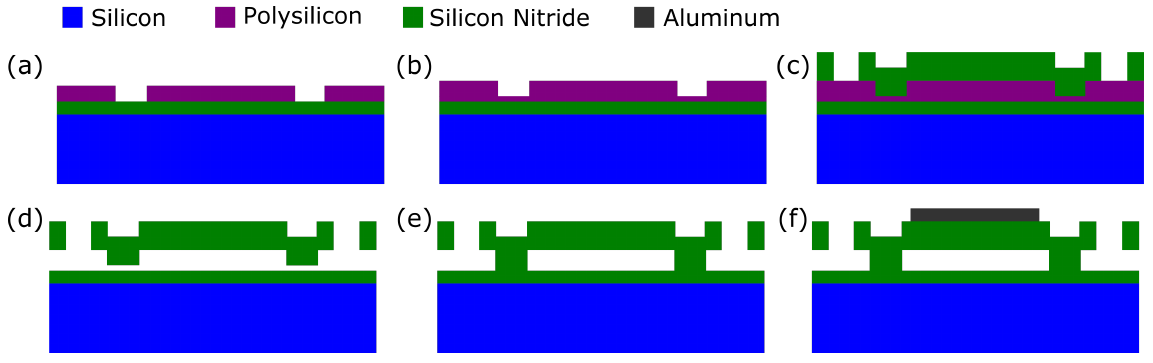
Figure 6. Sacrificial release CMUT fabrication process. ( a ) Deposit silicon nitride. Deposit and pattern the sacrificial polysilicon layer. ( b ) Deposit the polysilicon sacrificial layer for the etch channels into the cells. ( c ) Deposit and pattern the silicon nitride top plate layer. ( d ) Etch the sacrificial polysilicon layer. ( e ) Deposit silicon nitride using low-pressure chemical vapor deposition (LPCVD) to seal the cells. ( f ) Deposit and pattern the aluminum electrodes and